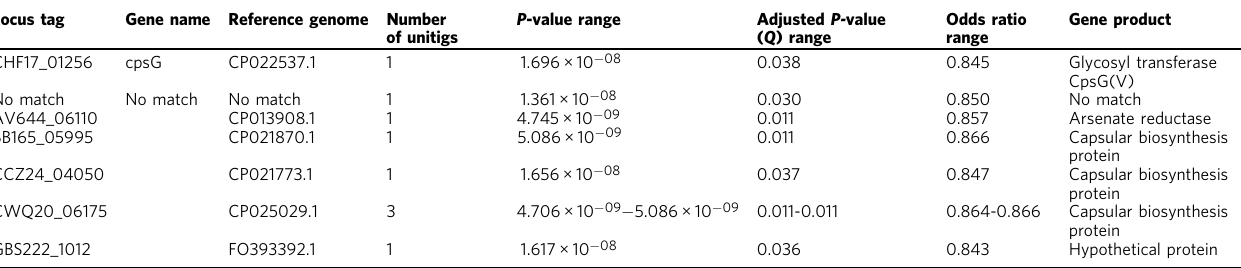
Table 1 Summary of the unitig sequences statistically associated with infection of the CNS in the GWAS using FaST-LMM. Locus